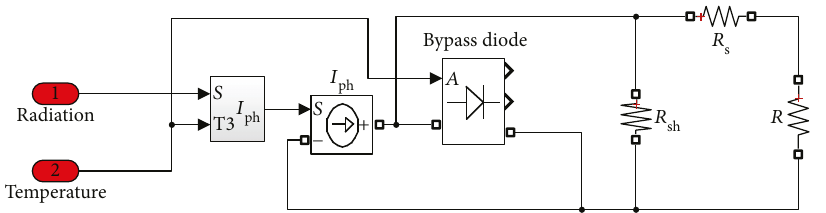
Figure 2: Simulink model of photovoltaic